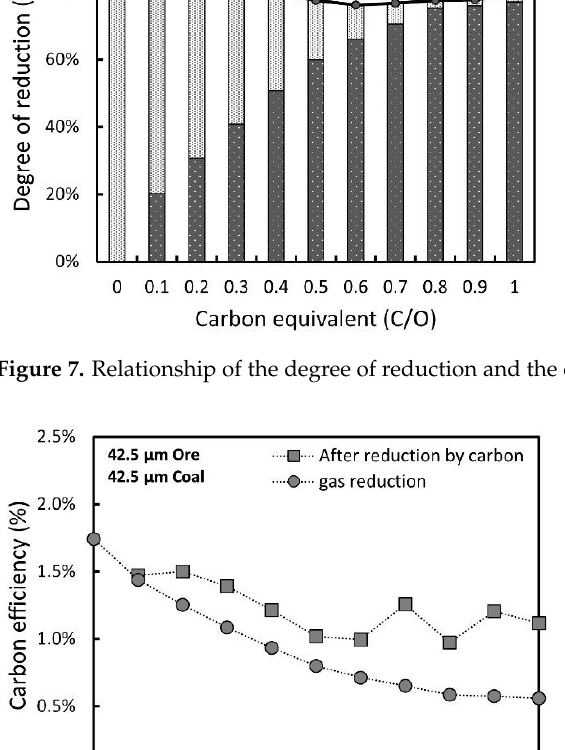
Figure 7. Relationship of the degree of reduction and the carbon equivalent.